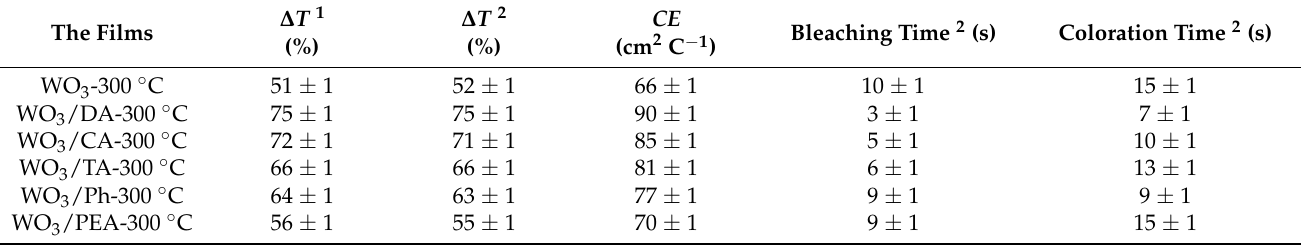
Table 1. EC properties of the WO 3 -300 ◦ C, WO 3 /DA-300 ◦ C, WO 3 /CA-300 ◦ C, WO 3 /TA-300 ◦